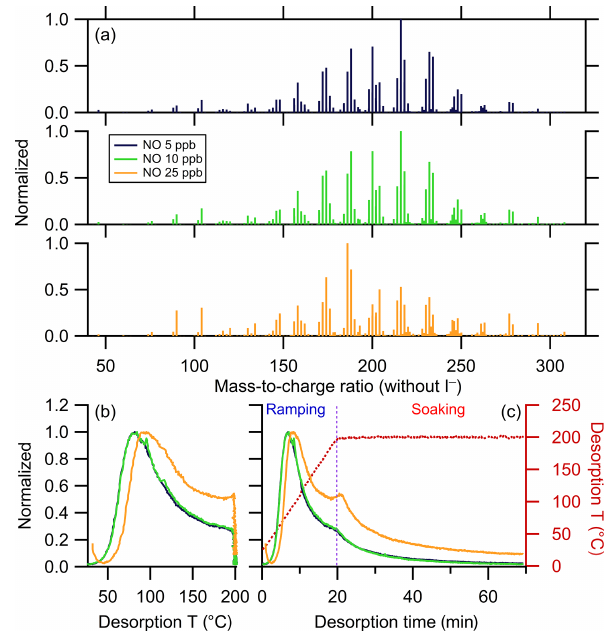
Figure 8. (a) Mass spectra of α -pinene + OH SOA formed with dif- ferent NO concentrations, normalized to the mass concentration of the most abundant ions. The mass excludes iodine. Normalized ther- mograms of the bulk SOA versus (b) temperature and (c) desorption time, with the desorption temperature shown as a dark red dashed line. The vertical purple dashed line delineates between ramping and soaking. In all the panels, colors correspond to the NO concen- tration (see